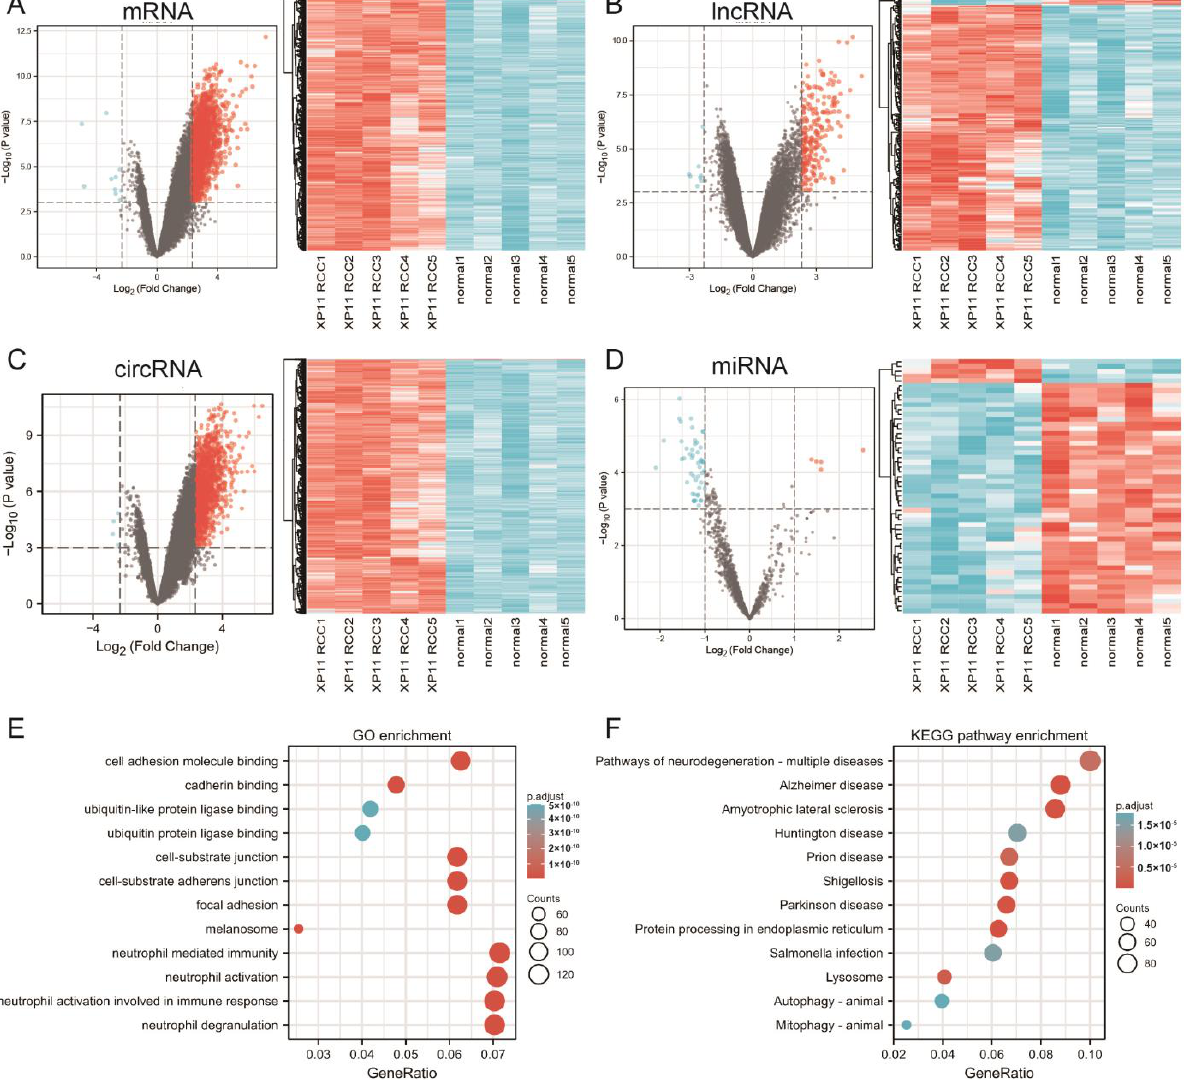
Figure 1. ( A–D ) Heatmaps and volcano maps of the DEmRNA ( A ), DElncRNA ( B ), DEcircRNA ( C ), and DEmiRNA ( D ). The red color represents upregulation, and the blue color represents downregulation. ( E ) Top 12 GO enrichment terms of DEmRNA. ( F ) Top 12 KEGG enrichment pathway of DEmRNA.